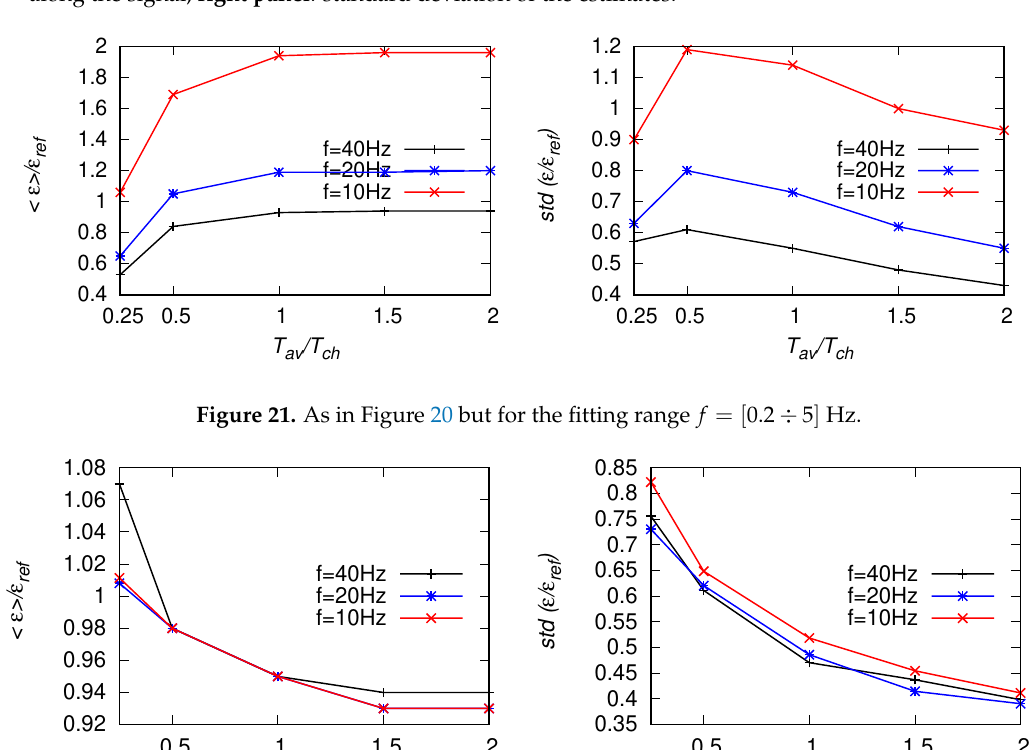
Figure 20. Statistics of (cid:101) PS estimates based on the power spectra, Equation (6), for the fitting range f = [ 1 ÷ 5 ] Hz, from POST signals [15] with f s = 40 Hz, 20 Hz and 10 Hz. Left panel : EDR averaged along the signal, right panel : standard deviation of the estimates.